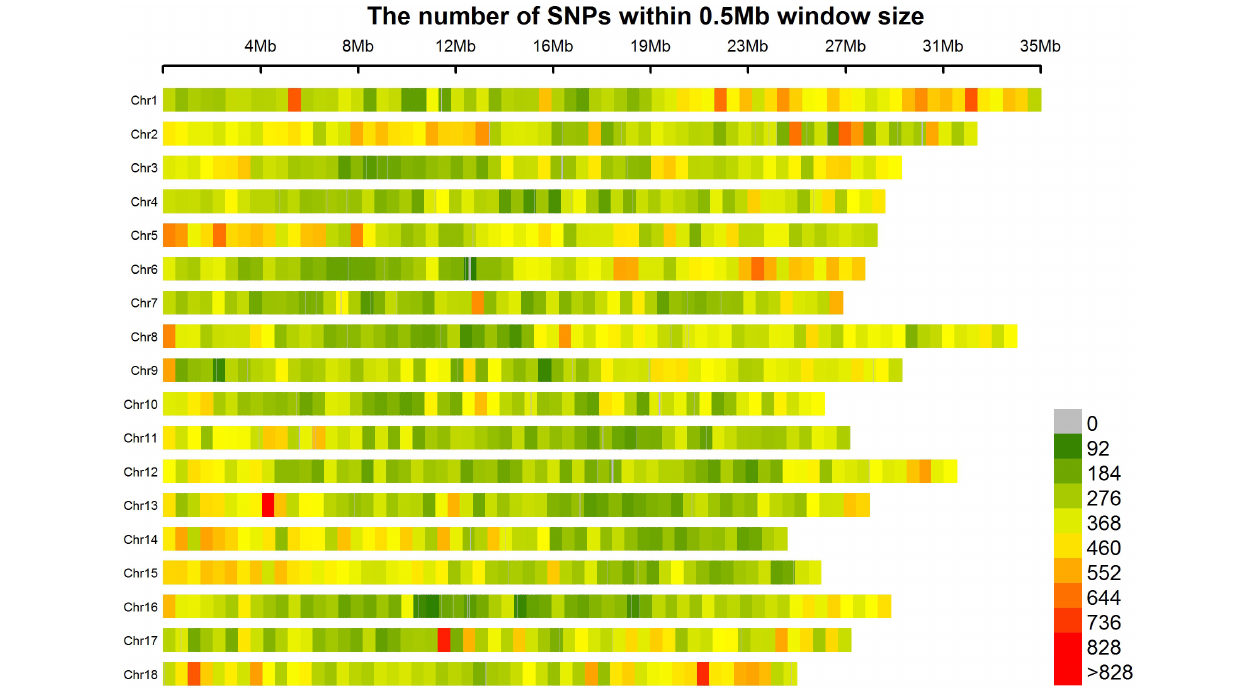
Frontiers in Plant Science |